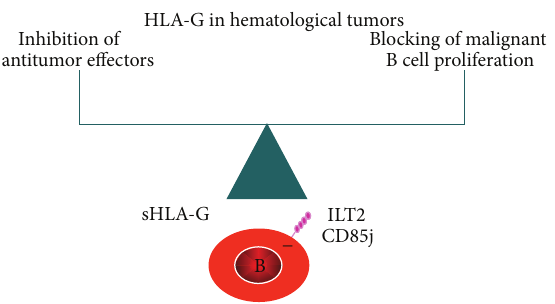
Figure 2: Dual role of HLA-G in hematological